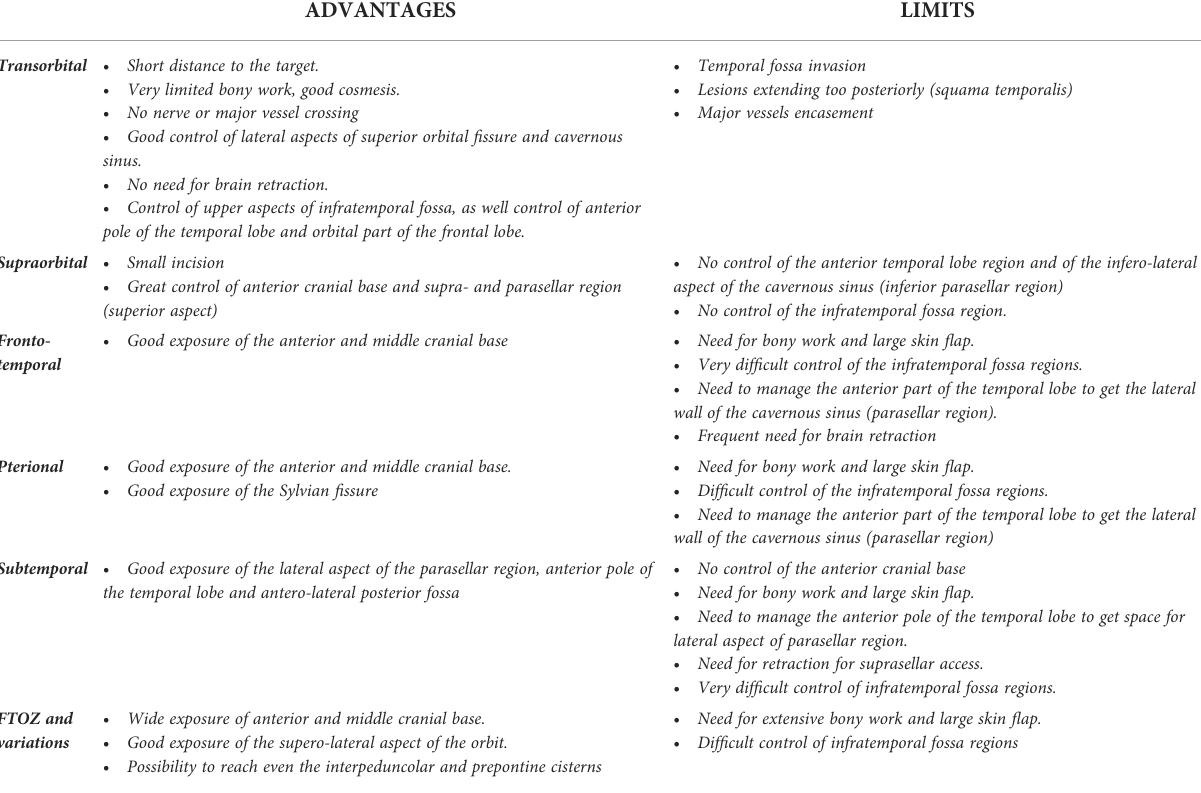
TABLE 1 Advantages and limits of TOEA and the most commonly used transcranial routes. ADVANTAGES